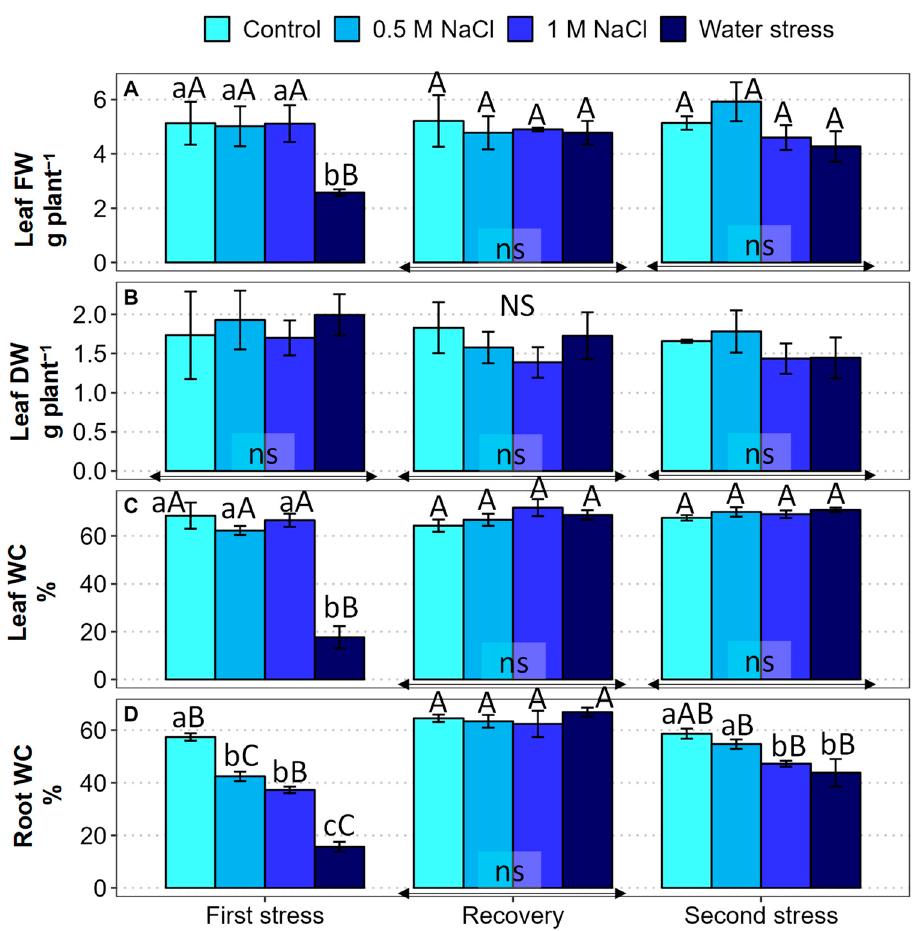
Figure 2. Effect of 30 days of stress treatments (First stress), followed by 15 days of watering with non-saline water (Recovery) and by additional 15 days of stress (Second stress) on ( A ) leaf fresh weight (Leaf FW), ( B ) leaf dry weight (Leaf DW), ( C ) leaf water content (Leaf WC), and ( D ) root water content (Root WC) of Limonium angustebracteatum plants. Different lowercase letters over the bars indicate significant differences between treatments (Control, 0.5 M NaCl, 1 M NaCl, and Water stress) for each sampling, at p ≤ 0.05; ns: non-significant. Different uppercase letters indicate significant differences between the three sampling times (First stress, Recovery, and Second stress) for each treatment, at p ≤ 0.05; ns: non-significant. Vertical bars indicate standard error (n =